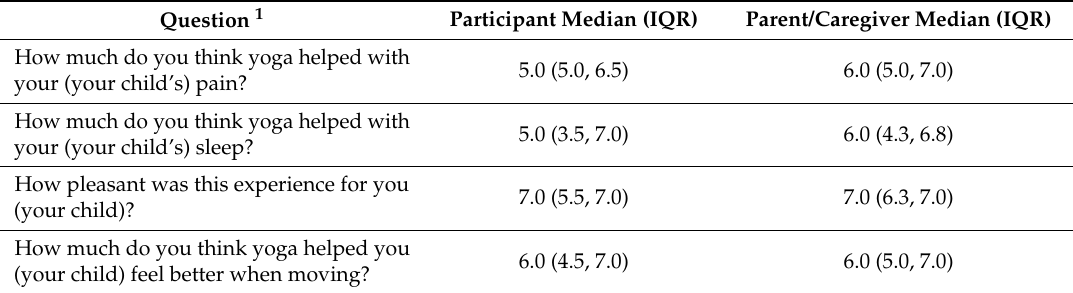
Table 3. Participant and parent responses to questions about the yoga experience.